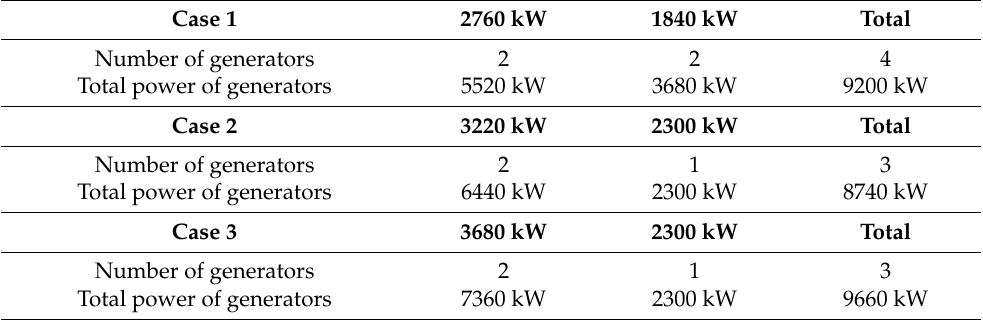
Table 4. Generator combinations for each